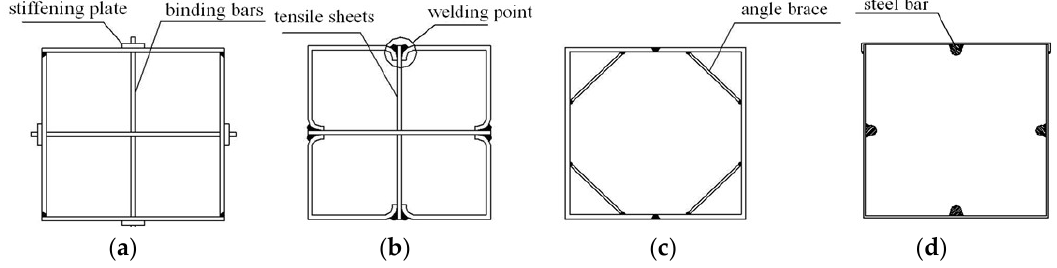
Figure 1. Comparison of existing stiffeners and steel-bar stiffeners. ( a ) Binding bar; ( b ) tensile sheet; ( c ) angle brace; ( d ) steel bar.